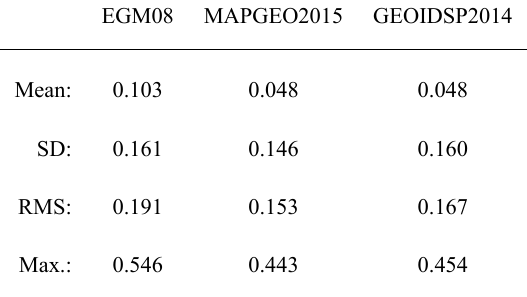
Consistency (in meters) of gravimetric geoids EGM08, MAPGEO2015 and GEOIDSP2014 regarding